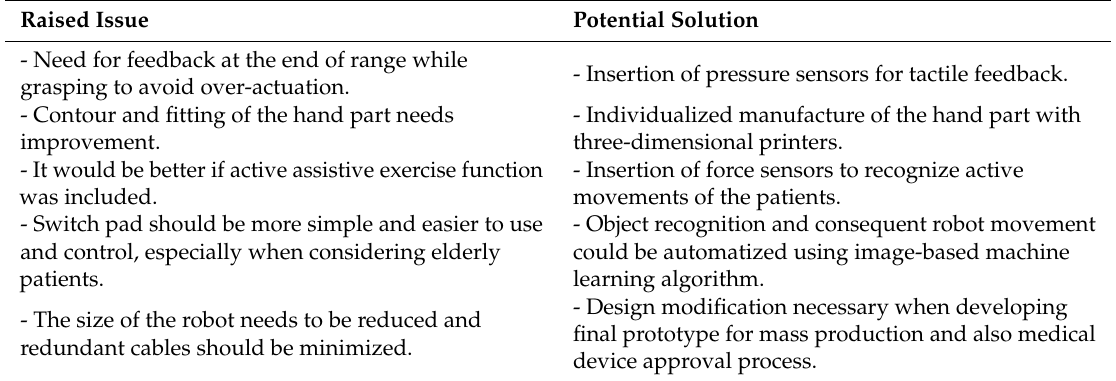
Table 1. Issues and potential solutions of the proposed distal upper limb rehabilitation robot from the usability test.